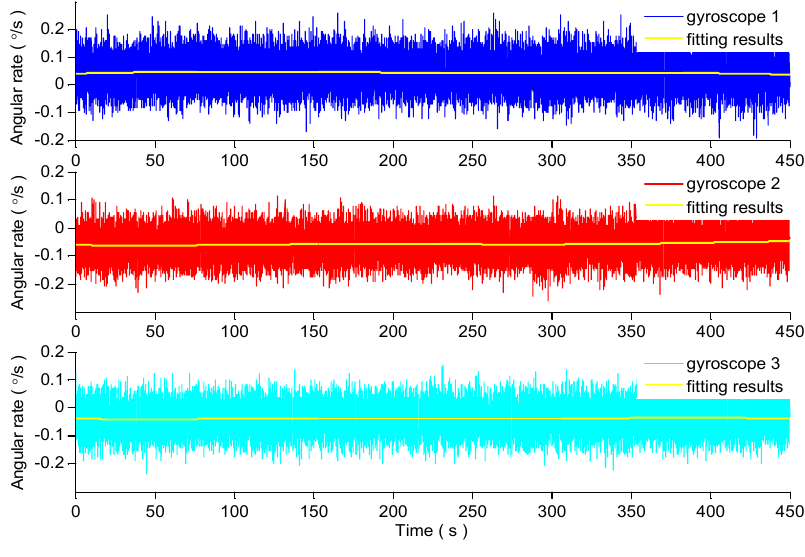
Figure 1. The original output signal of the three gyroscopes.